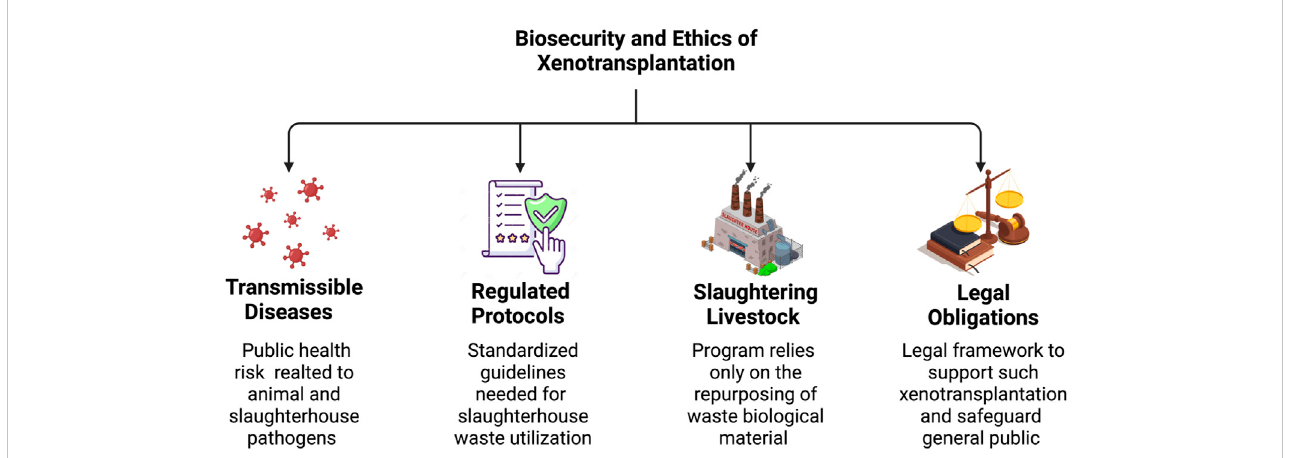
FIGURE 4 Biosecurityandethicalconsiderationsforutilizingslaughterhousewasteinxenotransplantation.The fi gureaboveprovidesabriefoverviewoftheethical aspects needed to support the development of xenografts using slaughterhouse waste, including the risk of transmissible diseases, regulated protocols needed to be followed, the humane and sustainable slaughtering of livestock, and legal